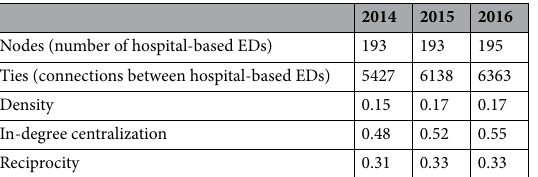
Table 3. The change in network statistics over time, 2014–2016. There were increased network density and in-degree centralization over